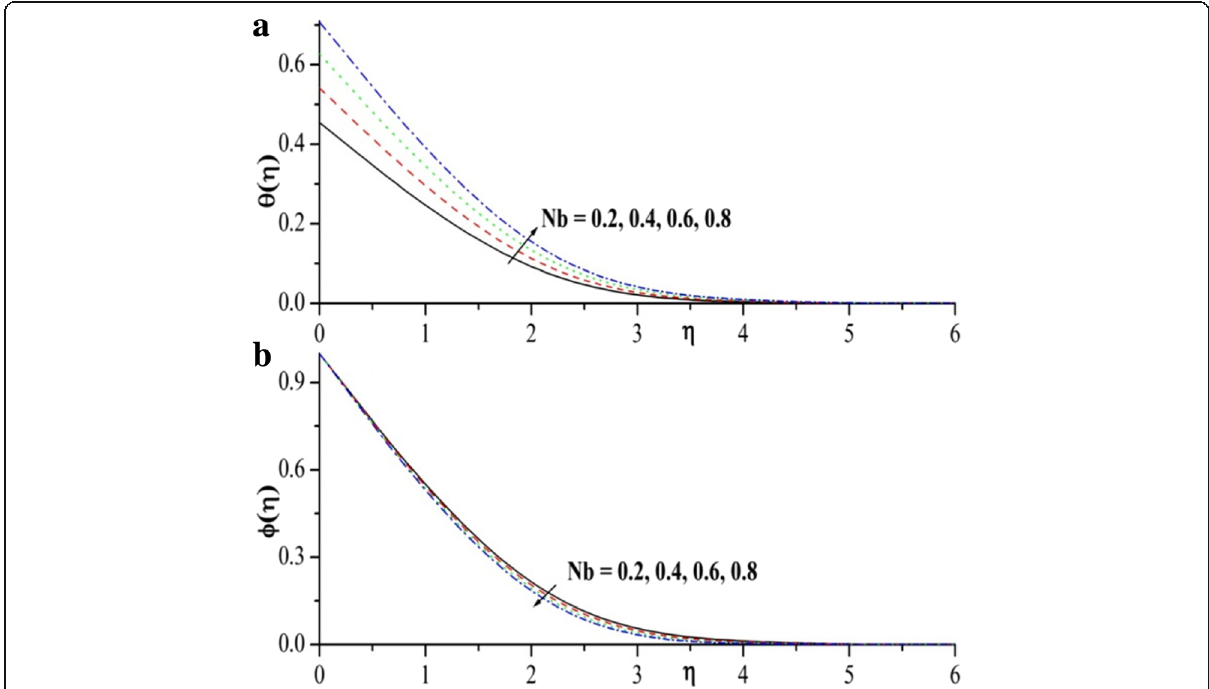
Fig. 16 a Temperature and b nanoparticle concentration profiles for variable values of Nb